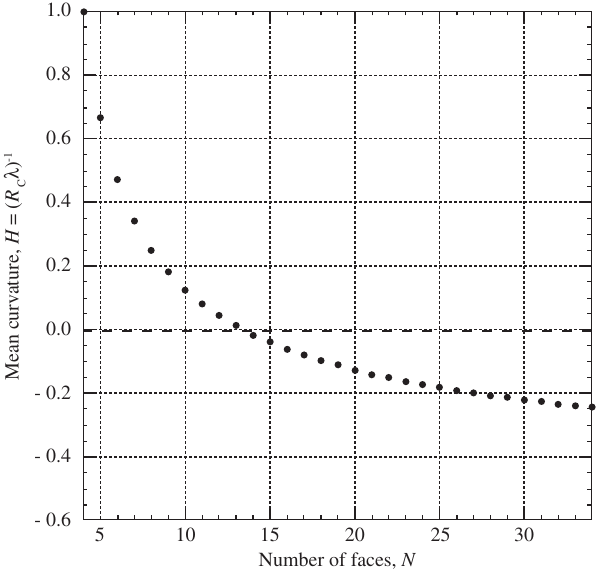
Figure 3. Mean curvature, H = 1/( R λ ) vs. number of faces on ANHs. The values of N cover the practical range encountered in network structures such as polycrystals and foams. The mean curvature divides the population of ANHs: for N ≤ 13 the mean curvatures are positive, implying shrinkage, whereas